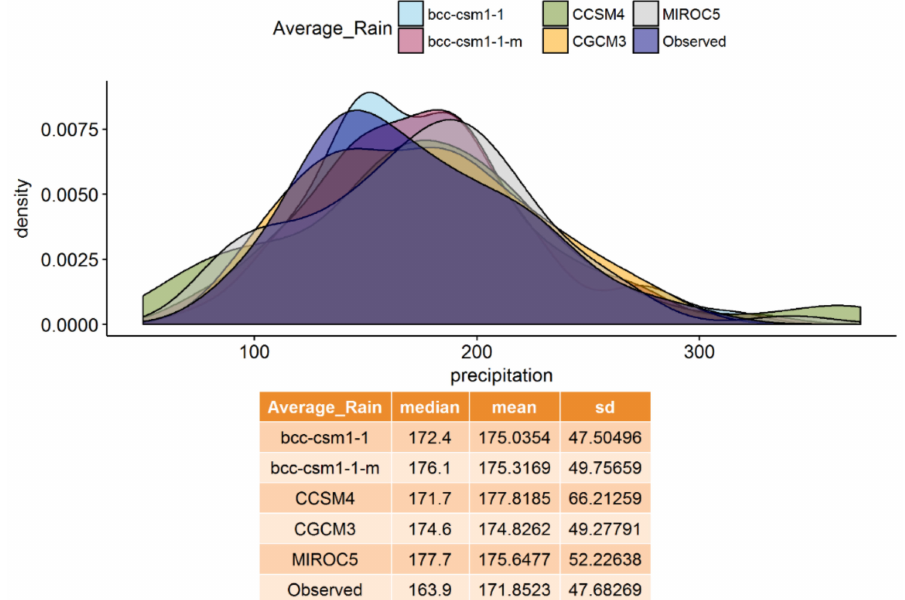
Figure 9. Density plots of the areal average of observed and modelled monthly precipitation in Iraq after bias